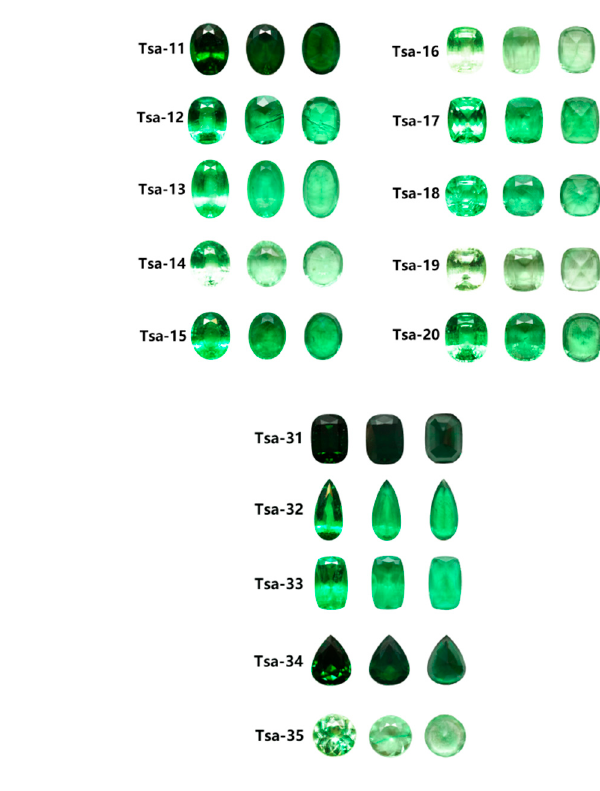
Figure 9. ( Left ) the obverse and reverse of a stone without the fire color (both stuck to the plasticine); ( Right ) the obverse of a gem with or without the fire color (stuck to the plasticine and placed on the white cushion).